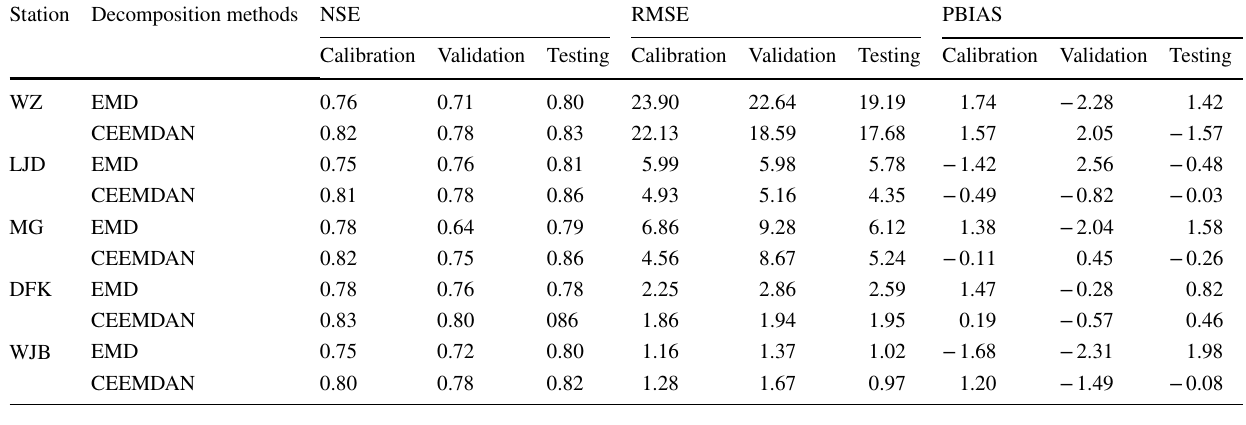
Fig. 15 Examples of the bound- ary effects for the VMD method on monthly runoff data at the WZ station: a , b sensitivity to appending one data point, c dif- ferences between sequential and concurrent testing decomposi- tions, and d differences between the summation of the sequential and concurrent testing decom-